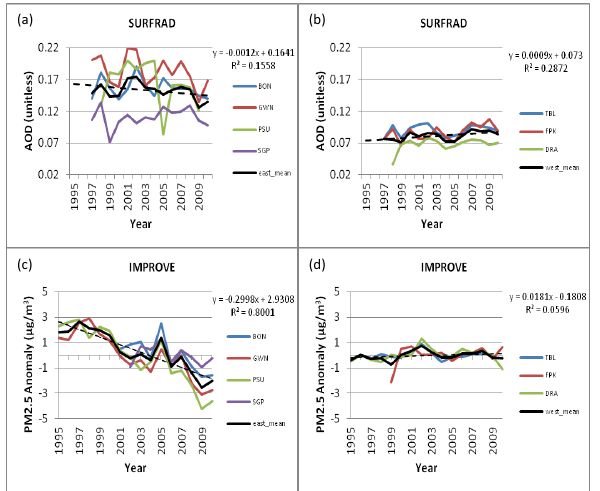
Figure 6: Annual anomalies of SO 4 (first row) and NO 3 (second row) from IMPROVE for 3 Fig. 6. Annual anomalies of SO 4 (top row) and NO 3 (bottom row) each site (colored line) and the network mean (solid black line) together with the LSF (dash 4 from IMPROVE for each site (colored line) and the network mean black line) to the network mean. The best-fit equation and coefficient of determination (R 2 ) 5 (solid black line) together with the LSF (dash black line) to the net- are given at right in each panel. The left column represent eastern US while the right column 6 work mean. The best-fit equation and coefficient of determination represent western US 7 ( R 2 ) are given at right in each panel. The left column represents eastern US while the right column represents western